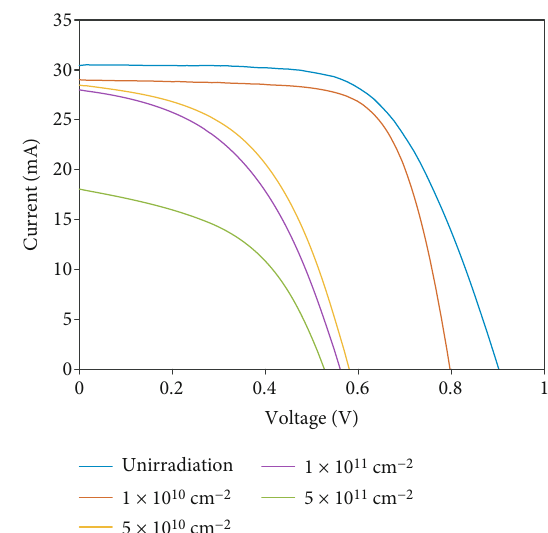
Table 1: The fl uence setting in irradiation experiment. Group Fluence (cm -2 ) Figure 2: The I ‐ V characteristics of the GaAs/Ge solar cell irradiated by 150 keV